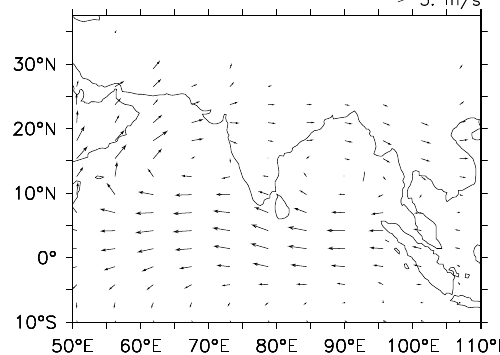
Fig. 13. Differences in June–September 850hPa winds (ms − 1 ) for the period 2070–2000 (under RCP-8.5) compared to the historic pe- riod (1970–2000) for the ensemble mean of all 19 models under consideration.